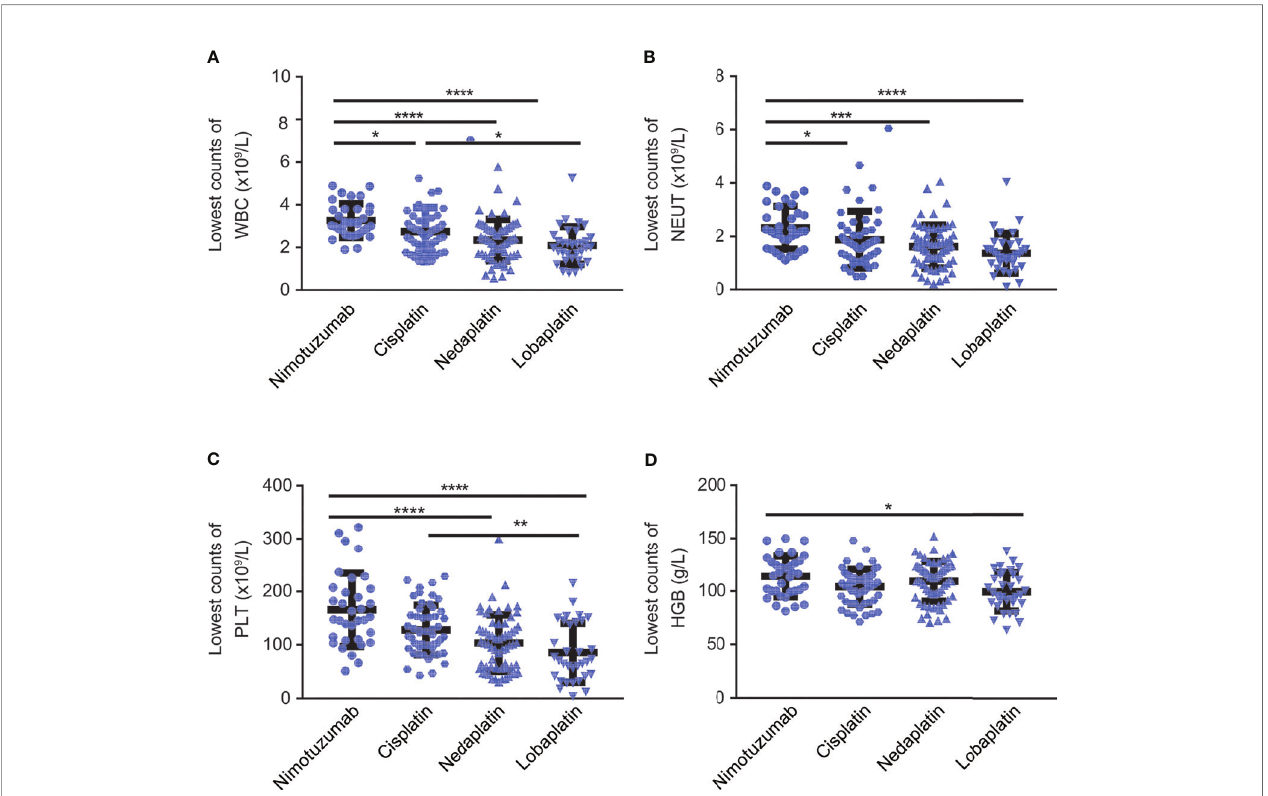
FIGURE 2 | The lowest counts of blood cell and hemoglobin counts during CCRT. Lowest count of (A) white blood cells, (B) neutrophils, (C) platelets, and (D) hemoglobin among LAHNC patients treated with nimotuzumab-, cisplatin-, nedaplatin- and lobaplatin-based concurrent chemoradiotherapy. WBC, white blood cell; NEUT, neutrophil; PTL, platelet; HGB, hemoglobin. *P < 0.05, **P < 0.01, ***P < 0.001, ****P <